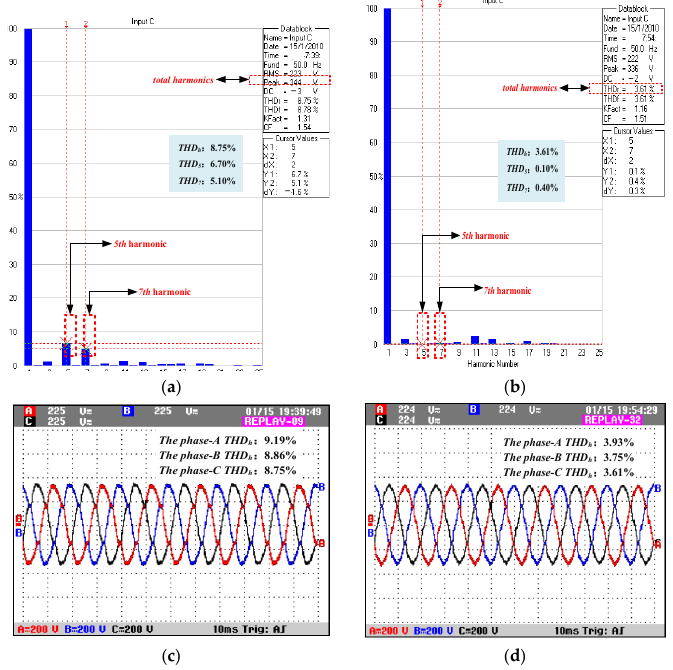
Figure 13. Output voltage waveforms of the nonlinear load: ( a ) C-phase harmonic percentage without compensation; ( b ) C-phase harmonic percentage with compensation; ( c ) voltage waveform before compensation; ( d ) voltage waveform after compensation.